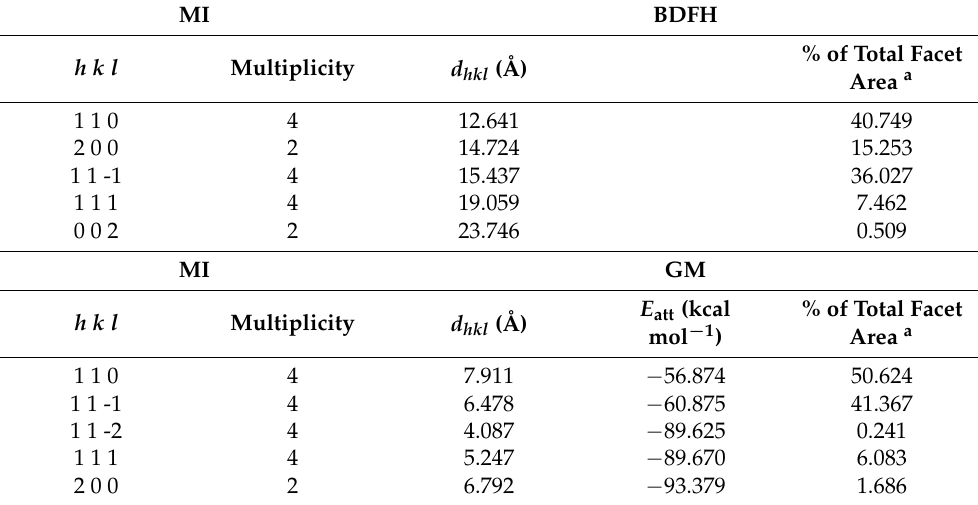
Figure 6. BDH crystal morphology prediction employing the GM ( left ) and BFDH ( right ) methods, respectively. MI faces are reported in round brackets. (002) is missing in the GM model (Table 4) and present in the BFDH prediction only. Table 4. MI faces and morphology predictions for DBH calculated by BFDH (upper) and GM (lower) methods.